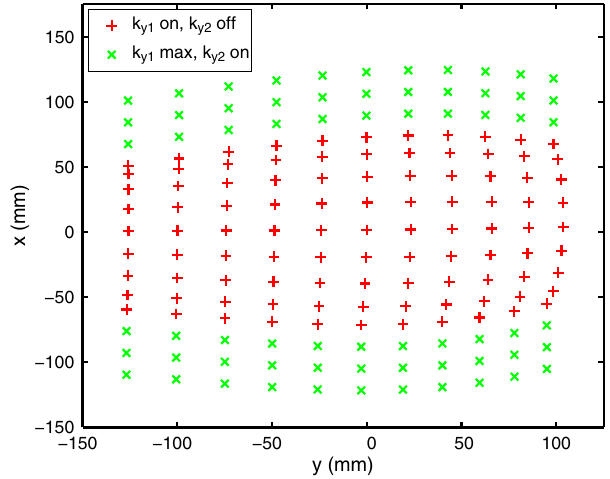
FIG. 22. Extension of the out-of-plane scanning range at Δ p=p ¼ − 5% using a second out-of-plane sweeper magnet located just down stream of B3.